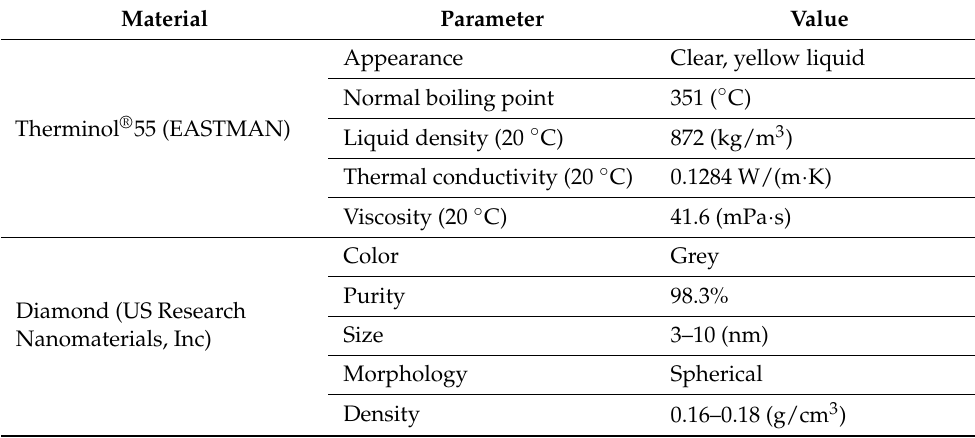
Table 2. Properties of the Material used for nanofluid Formulation.